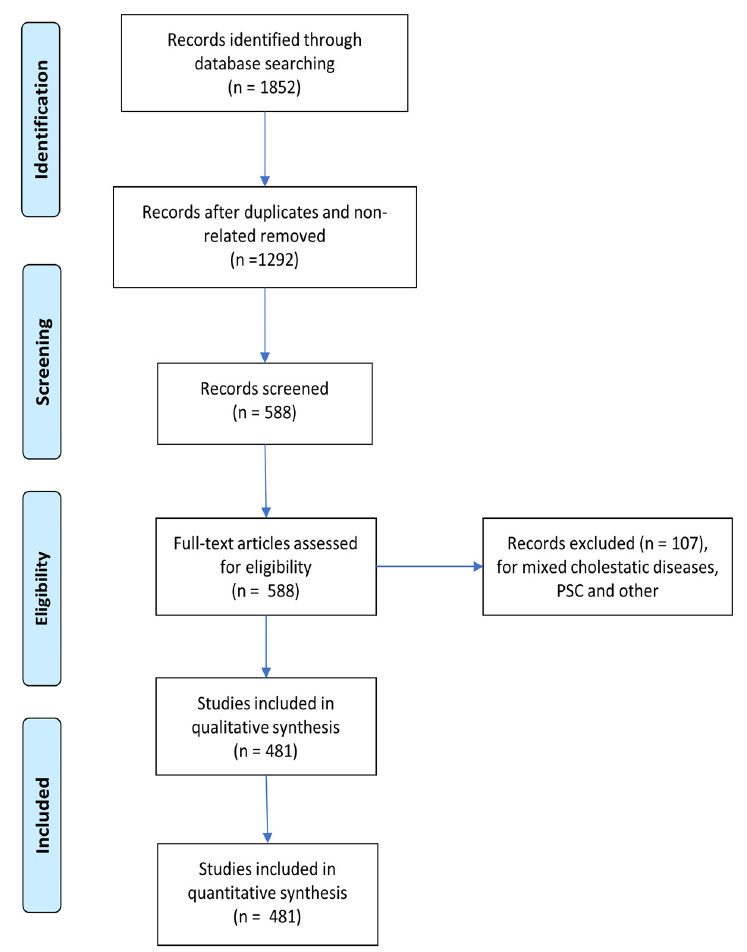
Figure 1. PRISMA flow diagram for study